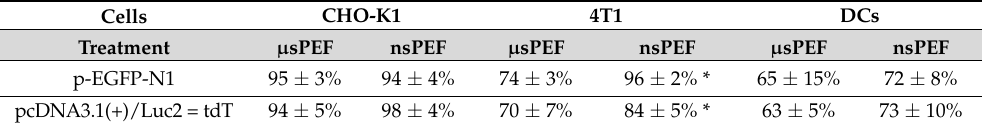
Table 1. Viability of cells after electrotransfection normalized to untreated control. Asterisk (*) cor- responds to statistically significant difference ( p < 0.05) versus µsPEF procedure.